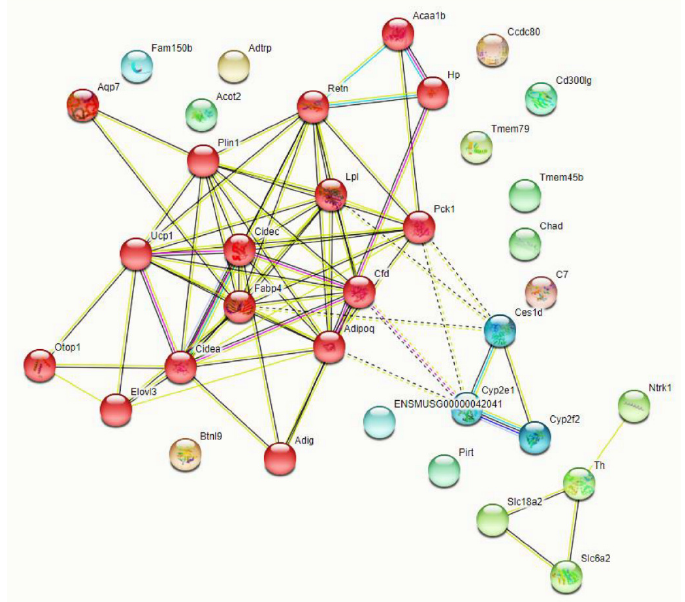
Figure 7. String analyses of genes that were upregulated in injured spinal cord from TG2-A-cKO compared to TG2fl/fl mice. Red hubs are genes that are directly involved in fatty acid metabolism, lipid storage and energy pathways.